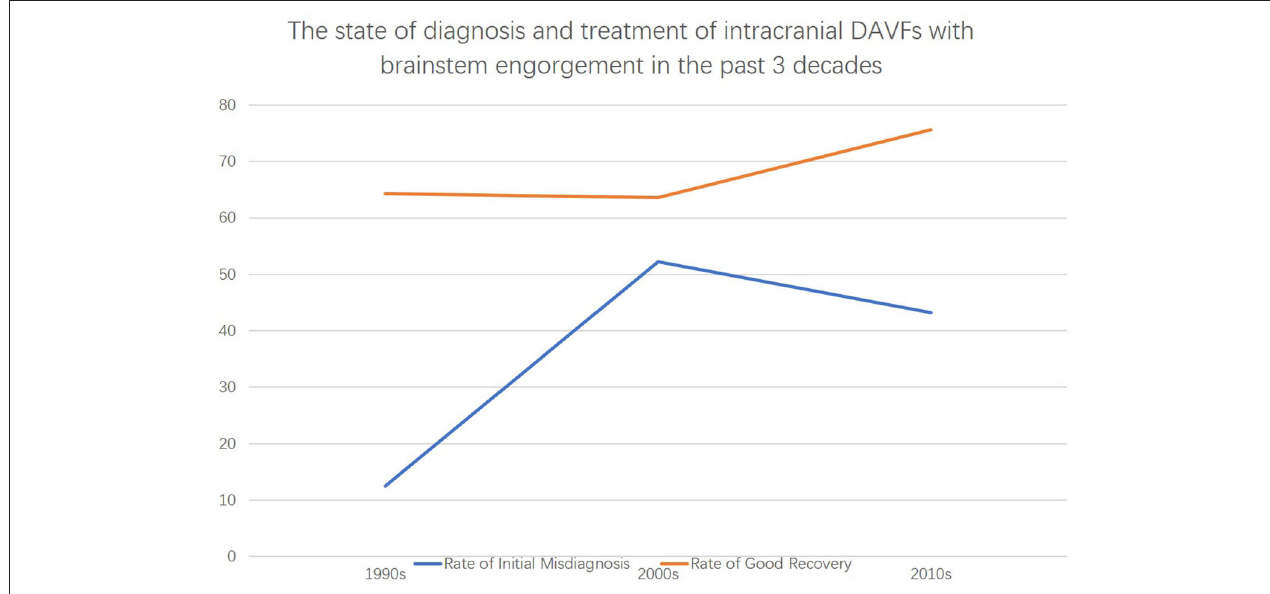
FIGURE 6 | The state of diagnosis and treatment of intracranial DAVFs complicated with brainstem engorgement in the past three